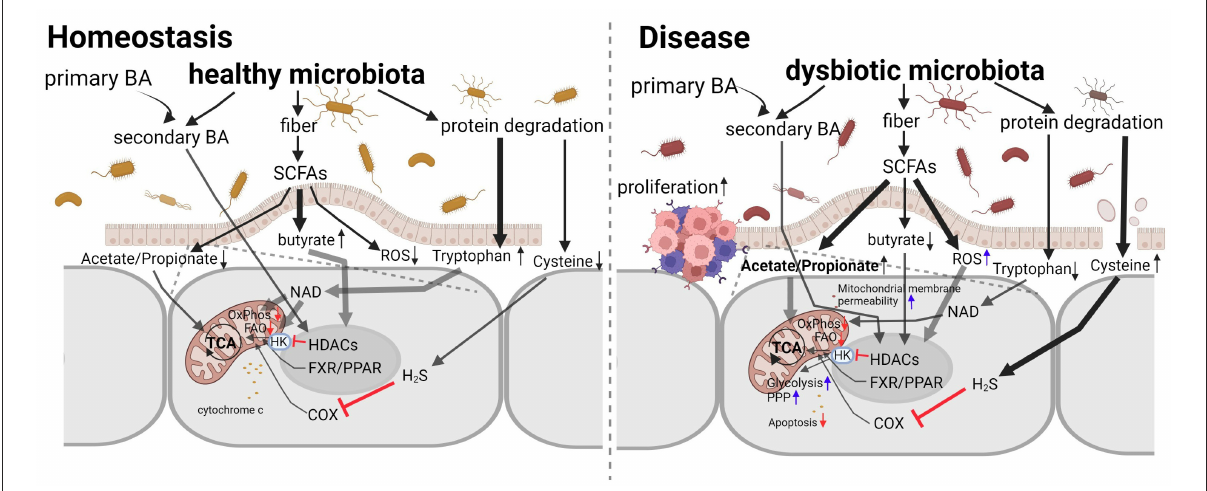
FIGURE1 The interaction between microbiota and mitochondria in homeostasis and disease. Microbiota, both healthy and dysbiotic, produce factors that increase or decrease mitochondrial activity and intracellular ROS levels. Interventions targeting the microbiota to restore normal mitochondrial functions are promising novel therapeutic approaches for intestinal inflammation and cancer due to their plasticity in counteracting mitochondrial metabolic reprogramming. Adapted from Weber-Stiehl et